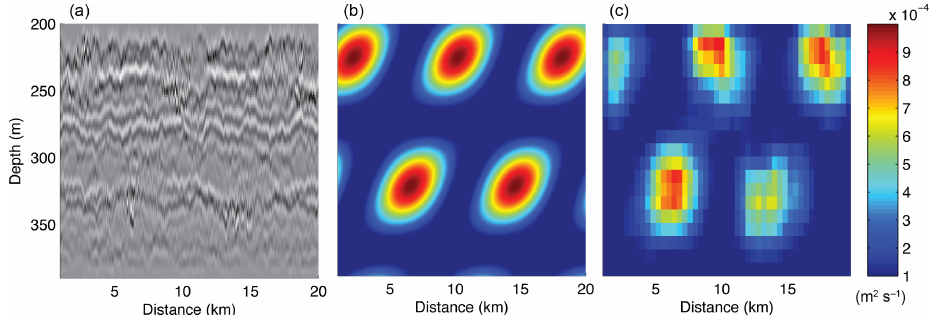
Figure 13. (a) Synthetic seismic data where reflections represent fine structure calculated from an XCTD density profile disrupted by an internal wave field with energy in the turbulent subrange applied fitting the sheared checkerboard pattern shown in (b) . The recovered turbulent diffusivity from the seismic slope spectra method developed here is shown in (c)